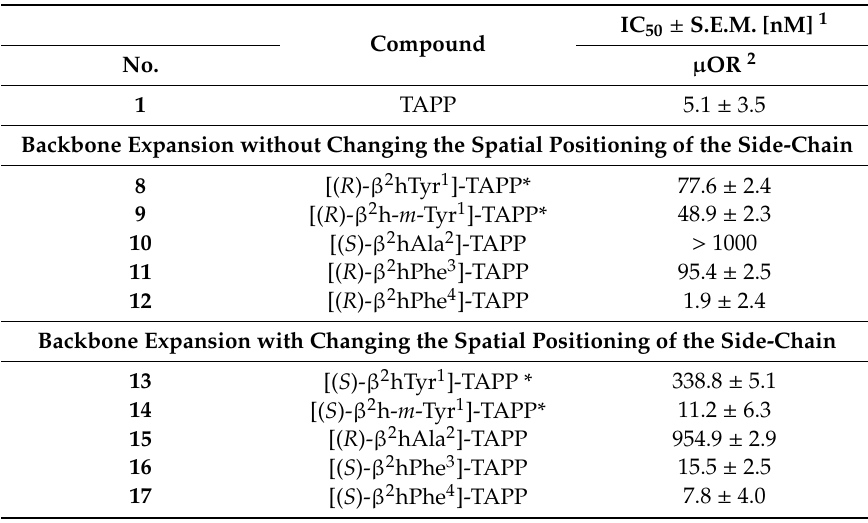
Table 1. Binding a ffi nity of the studied